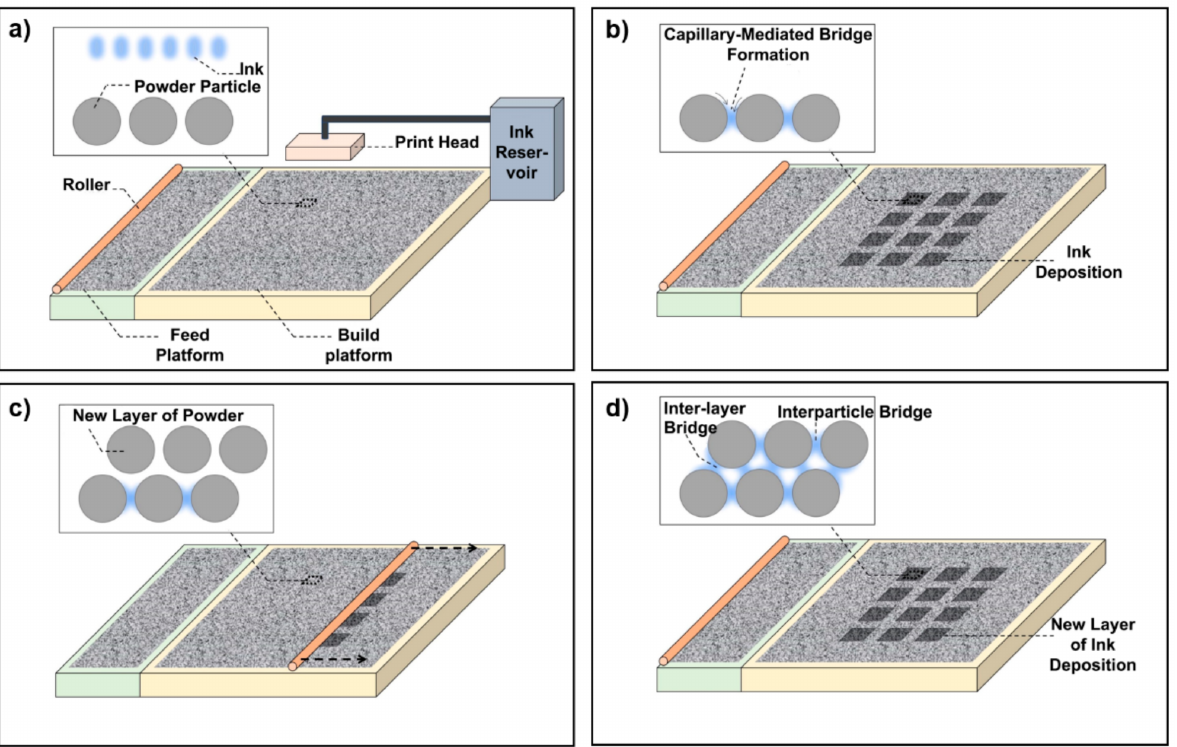
Figure 2. The capillary-mediated binderless AM process involves the following steps: ( a ) deposition of the ink onto the uppermost layer of AZ91 powder, ( b ) creation of a capillary-mediated liquid bridge within the interparticle gaps and their gradual transition into solid bridges, ( c ) dispensation of the ink in the desired area after the delivery and spreading of a new layer of powder on top of the previous one, and ( d ) formation of liquid bridges within the new layer as well as the preceding